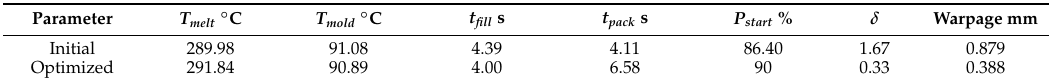
Table 14. Conventional parameters and warpage results of the PC car light cover.